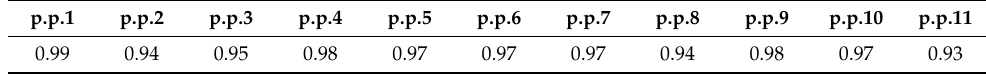
Table 3. Correlation coefficient between force and deflection.